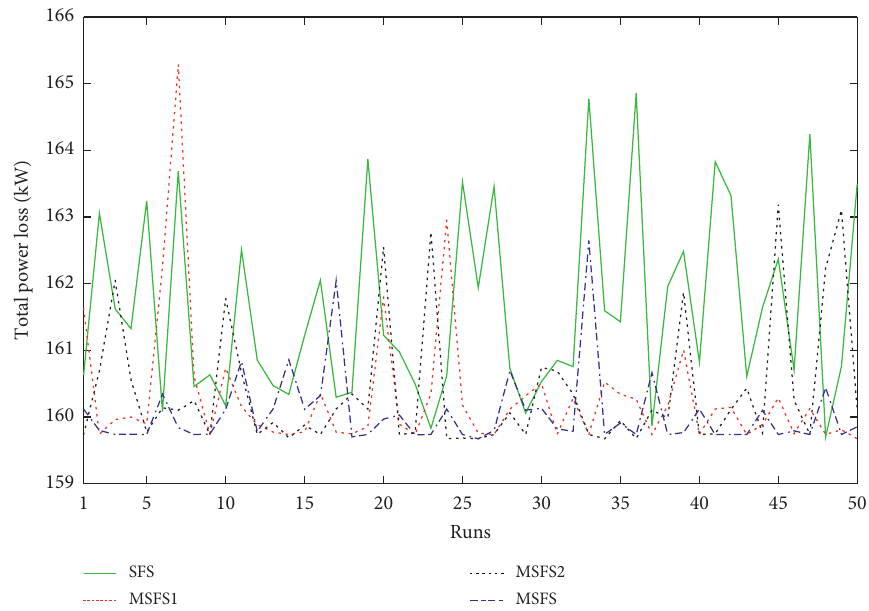
Figure 21: Total power loss of 50 trial runs obtained by SFS methods for case 1 of the 85-bus